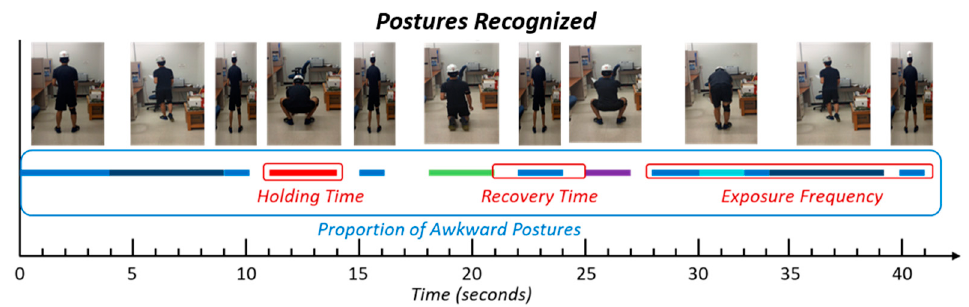
Figure 5. Posture recognition model output.